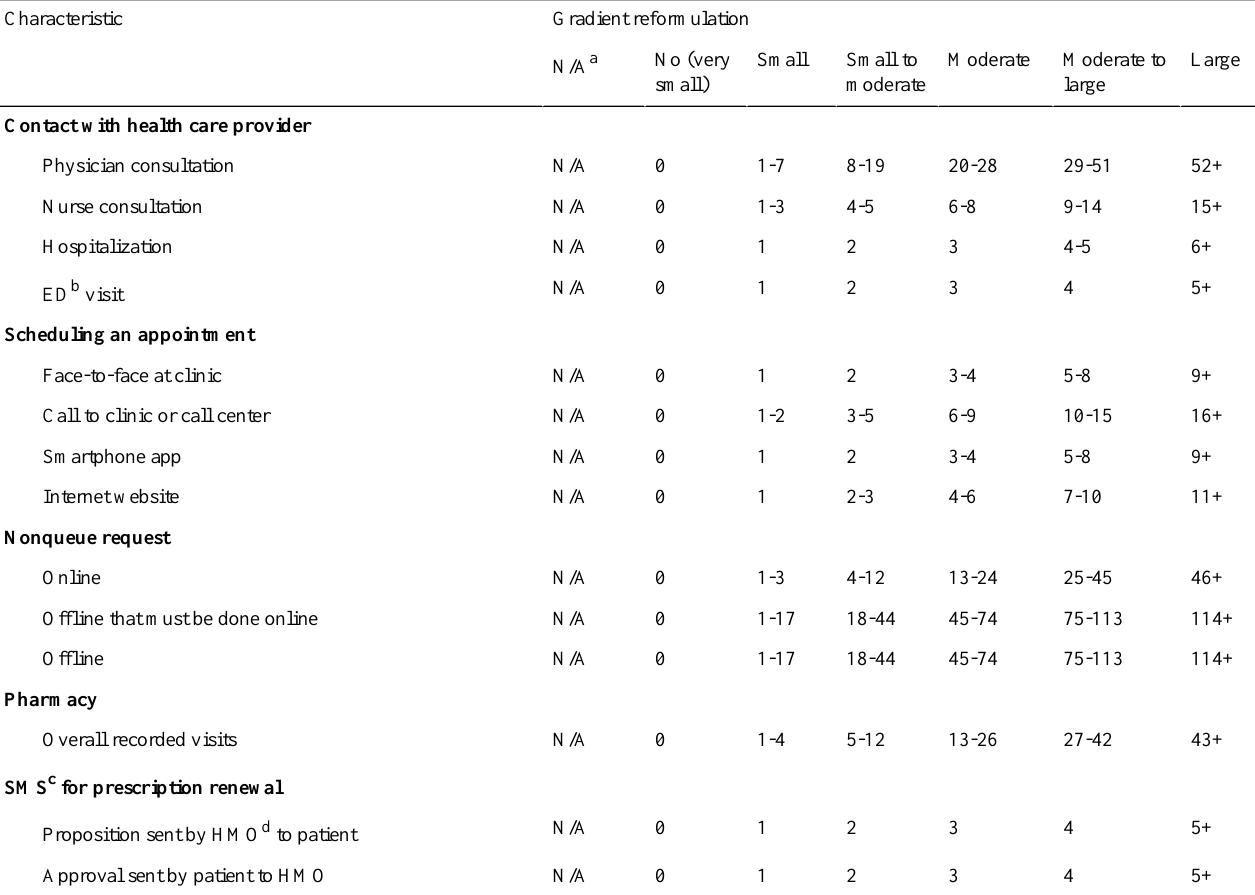
Table 1. Gradient reformulation and ranges of values related to each resource consumption level.